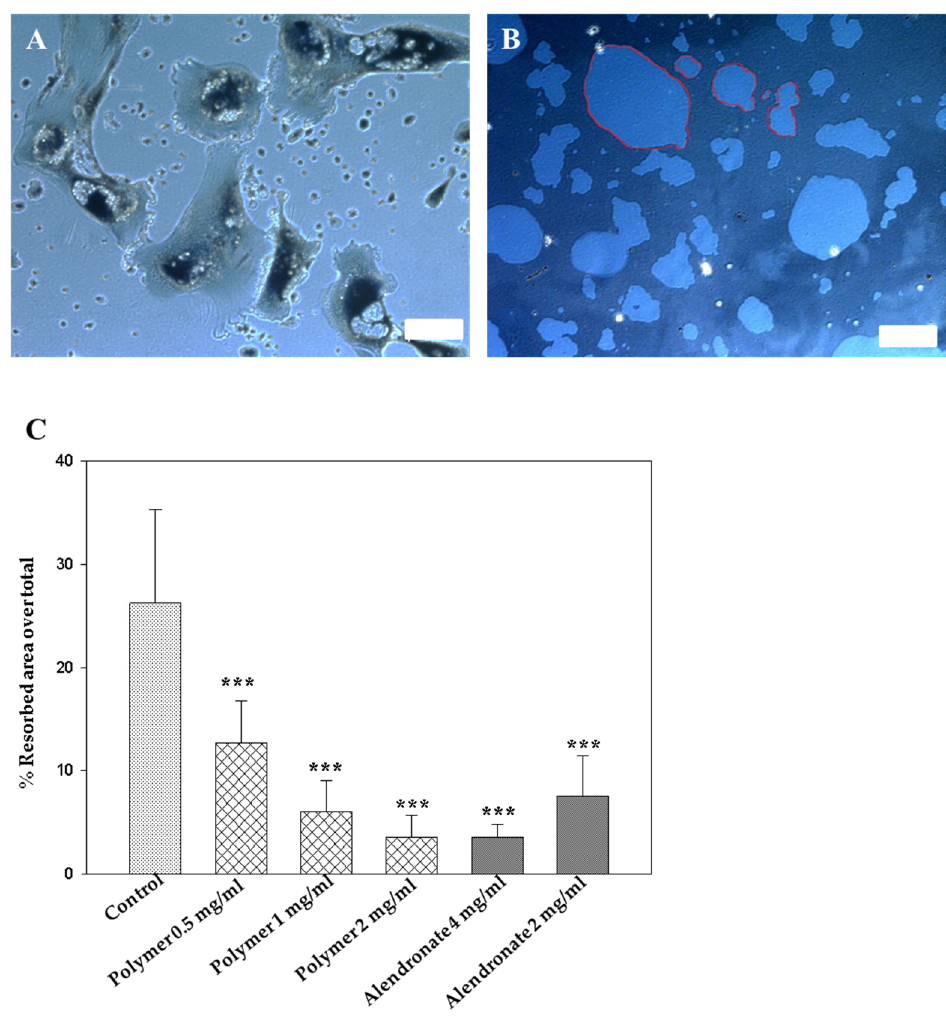
Figure 4. Synthetic polymer inhibits osteoclastic activity. ( A ) tartrate-resistant acid phosphatase (TRAP) staining of the osteoclasts, 10× (calibration = 100 µm); ( B ) pit assay: light areas—resorbed by osteoclasts, 10×(calibration = 100 µm); ( C ) quantitative analysis of pit assay: data are presented as a percentage of the resorbed area over the total area (data are presented as the mean ± SD, *** p ≤ 0.001, one-way ANOVA multiple comparisons with control group (Holm–Sidak